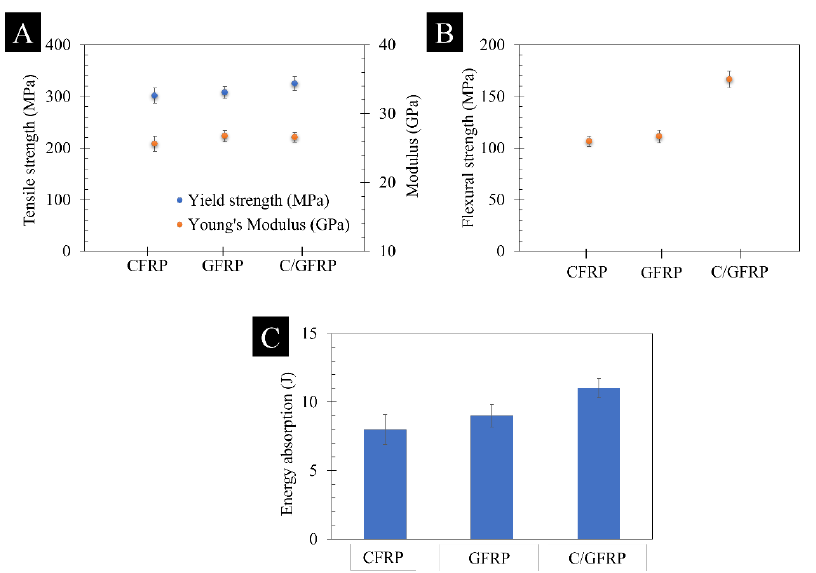
Figure 4. Mechanical properties of epoxy reinforced with CF and/or S-glass fiber composites: ( A ) tensile strength and Young’s modulus, ( B ) flexural strength, and ( C ) energy absorption of composites upon low-velocity impact.